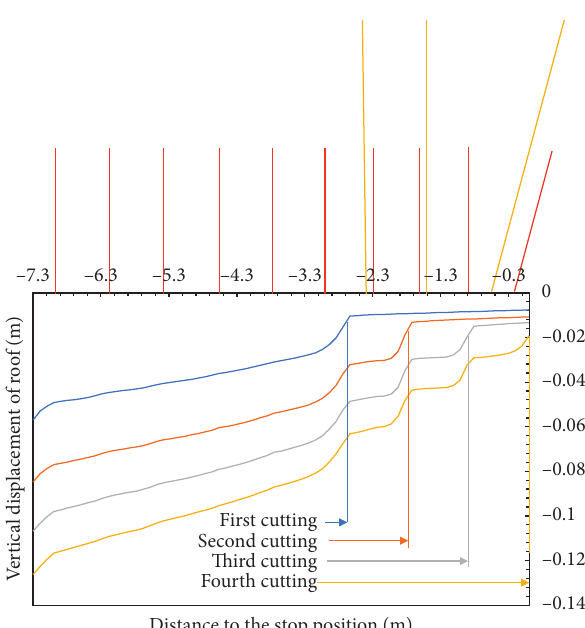
Figure 9: Variation of roof displacement during the formation of removal area.